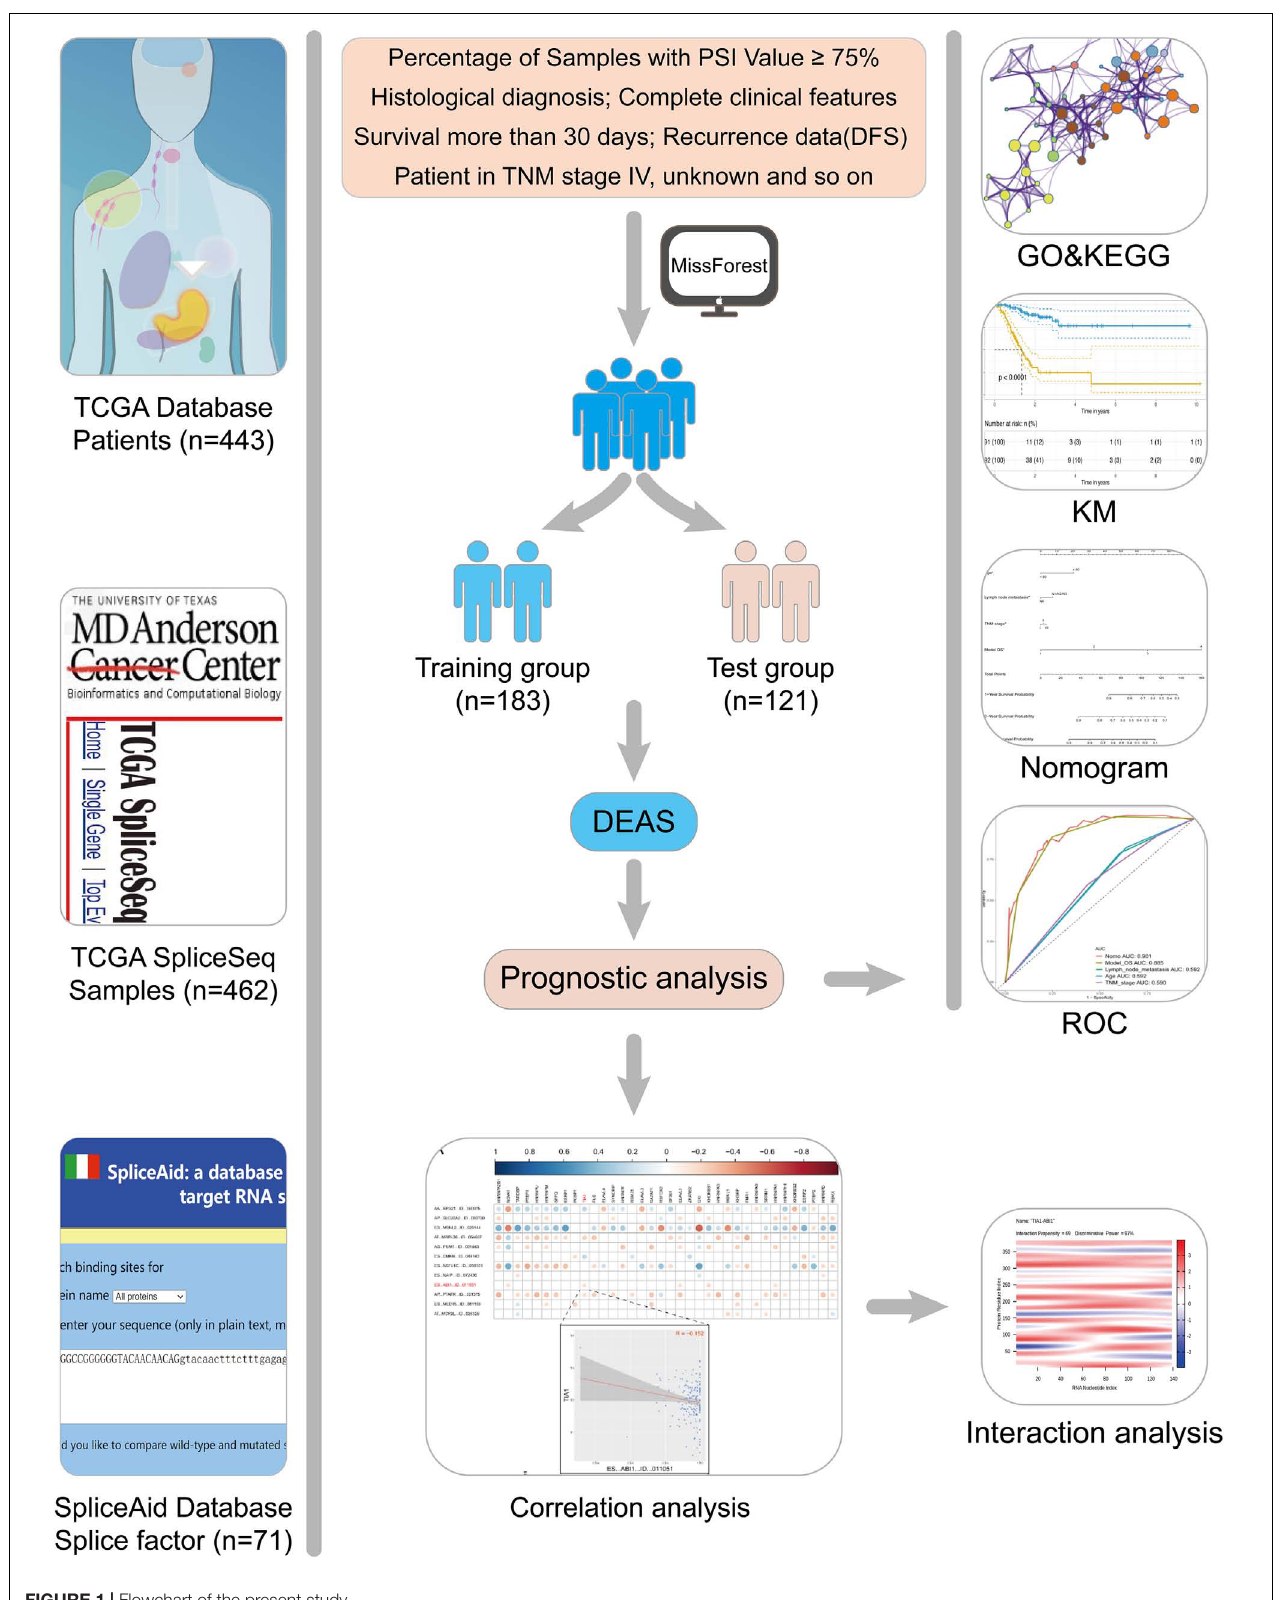
FIGURE 1 | Flowchart of the present